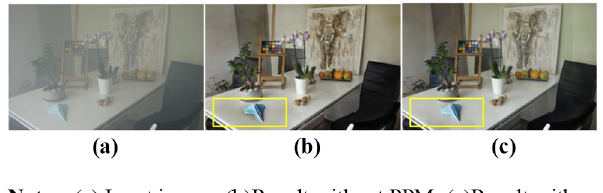
Figure 4. Image dehazing with/ without pyramid pooling module.